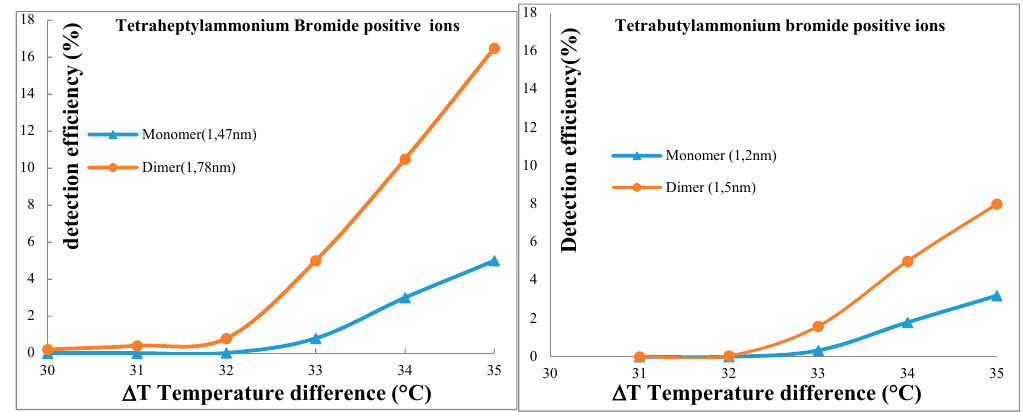
Figure 6. Detection efficiency of the CPC for THABr and TBABr ions for different Ts.